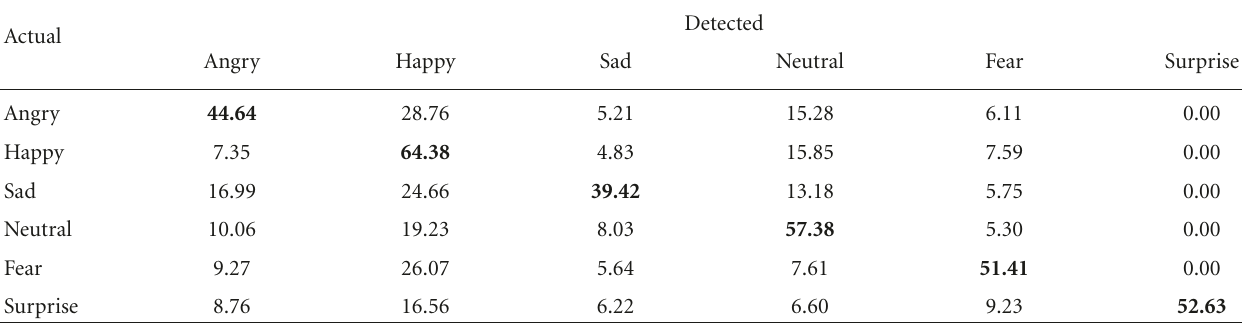
Table 5: Six emotions recognition rate (%) for a balanced speaker and text independent test-utterance based: 100 utterances per emotion, random sequence of speakers after LPF.